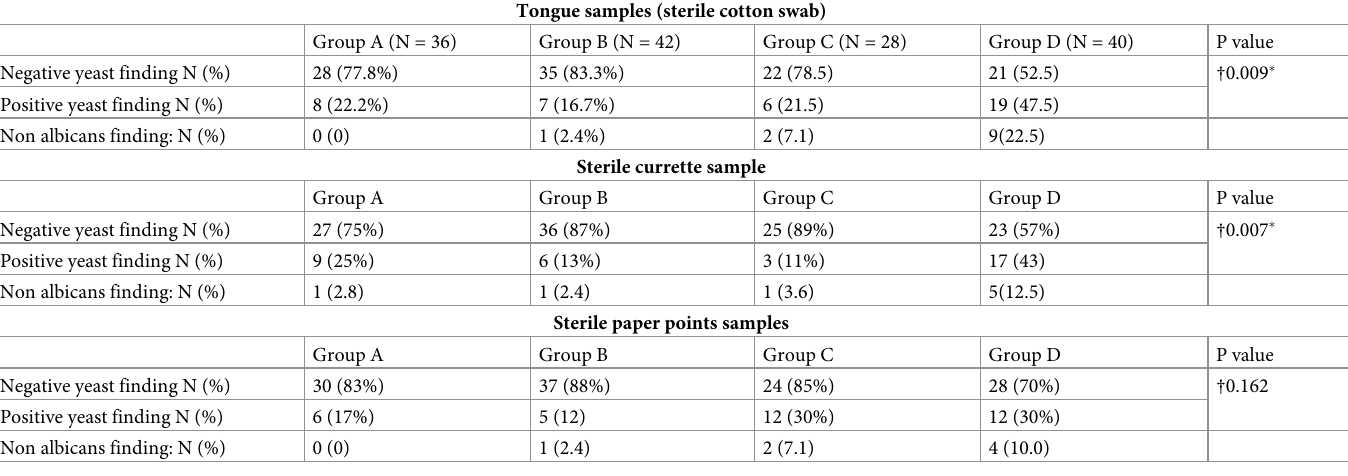
Table 2. Candida spp. finding on tongue and in subgingival areas sampled by sterile periodontal curette and sterile paper